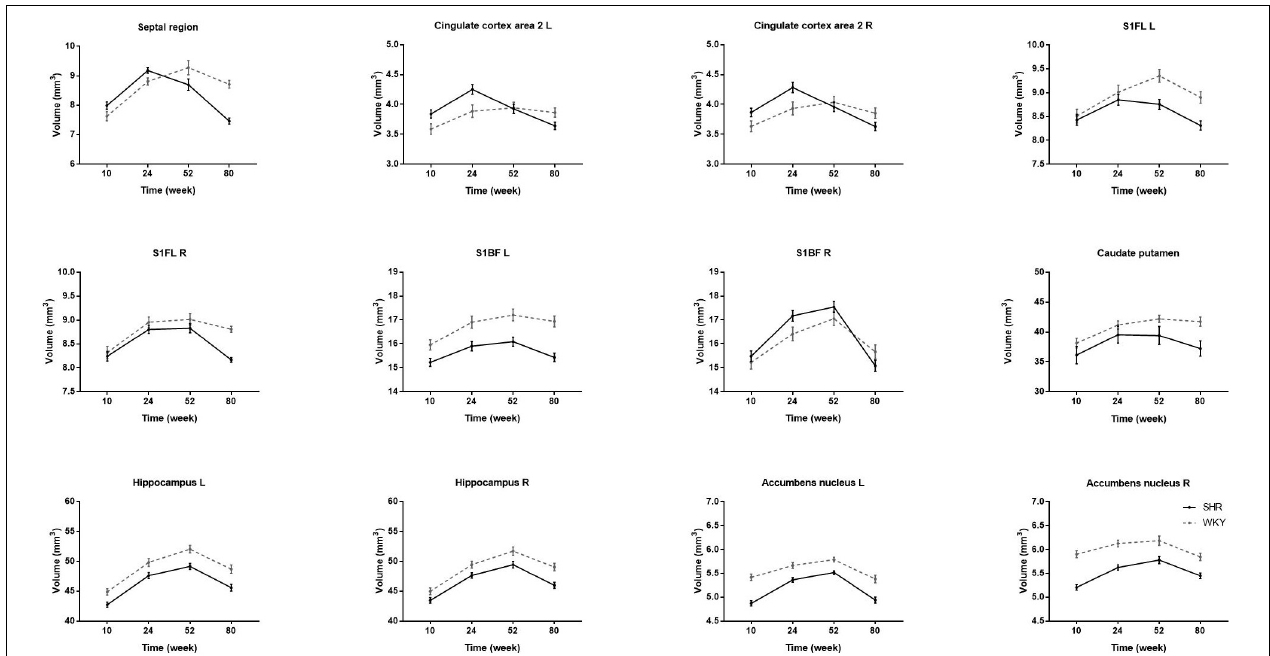
FIGURE 4 | Comparisons of longitudinal changes in each ROI volume in SHRs and WKY rats at 10, 24, 52, and 80 weeks old. The caudate putamen volume is the average volume of both sides because there was no significant bilateral difference in the two groups at any time point. Temporal trajectories of gray matter volume show obvious heterogeneity between the two groups. The trajectories of the volume change show an inverted-U shape in SHRs, increasing at the early phase and declining at the late phase. Compared with WKY rats, regional unbalanced volume atrophy is more pronounced in SHRs. The rate of gray matter atrophy is fastest in the right primary somatosensory cortex barrel field in elderly